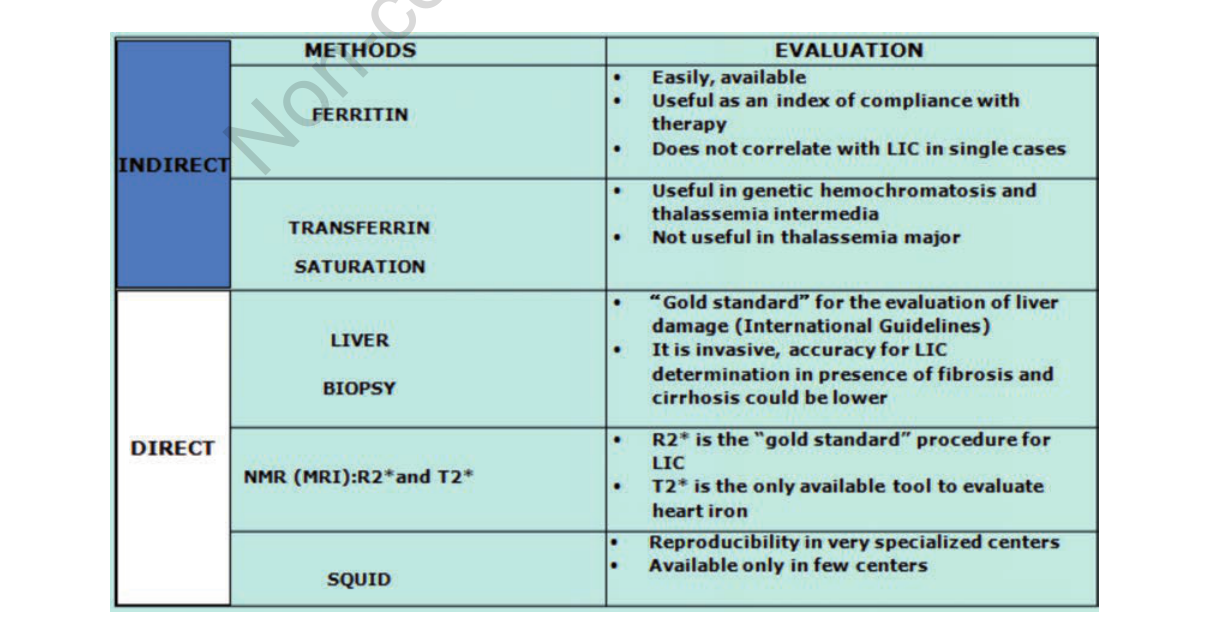
Figure 4. Kaplan-Meier survival curves in thalassemia major patients for single complication (Maggio et al. , 2012,unpublished data).